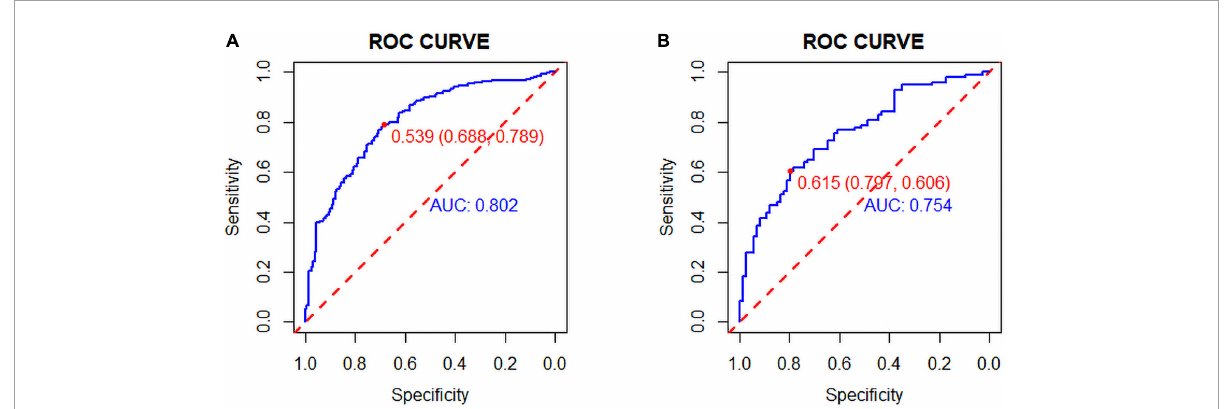
FIGURE3 (A) Training set and (B) Validation set: The pooled Area Under Curve (AUC) of the receiver operating characteristic (ROC) curve. The y-axis indicates the true positive rate of the risk prediction. The x-axis indicates the false positive rate of the risk prediction. The blue and red lines represent the performance of the nomogram.